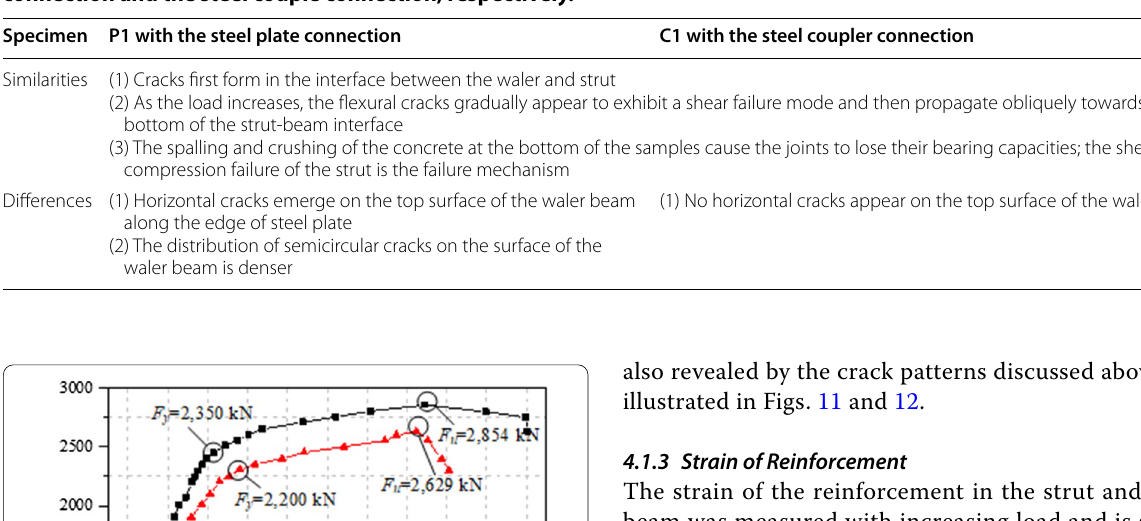
Table 2 Similarities of and differences in the observed failure characteristics of samples P1 and C1 with the steel plate connection and the steel couple connection, respectively.